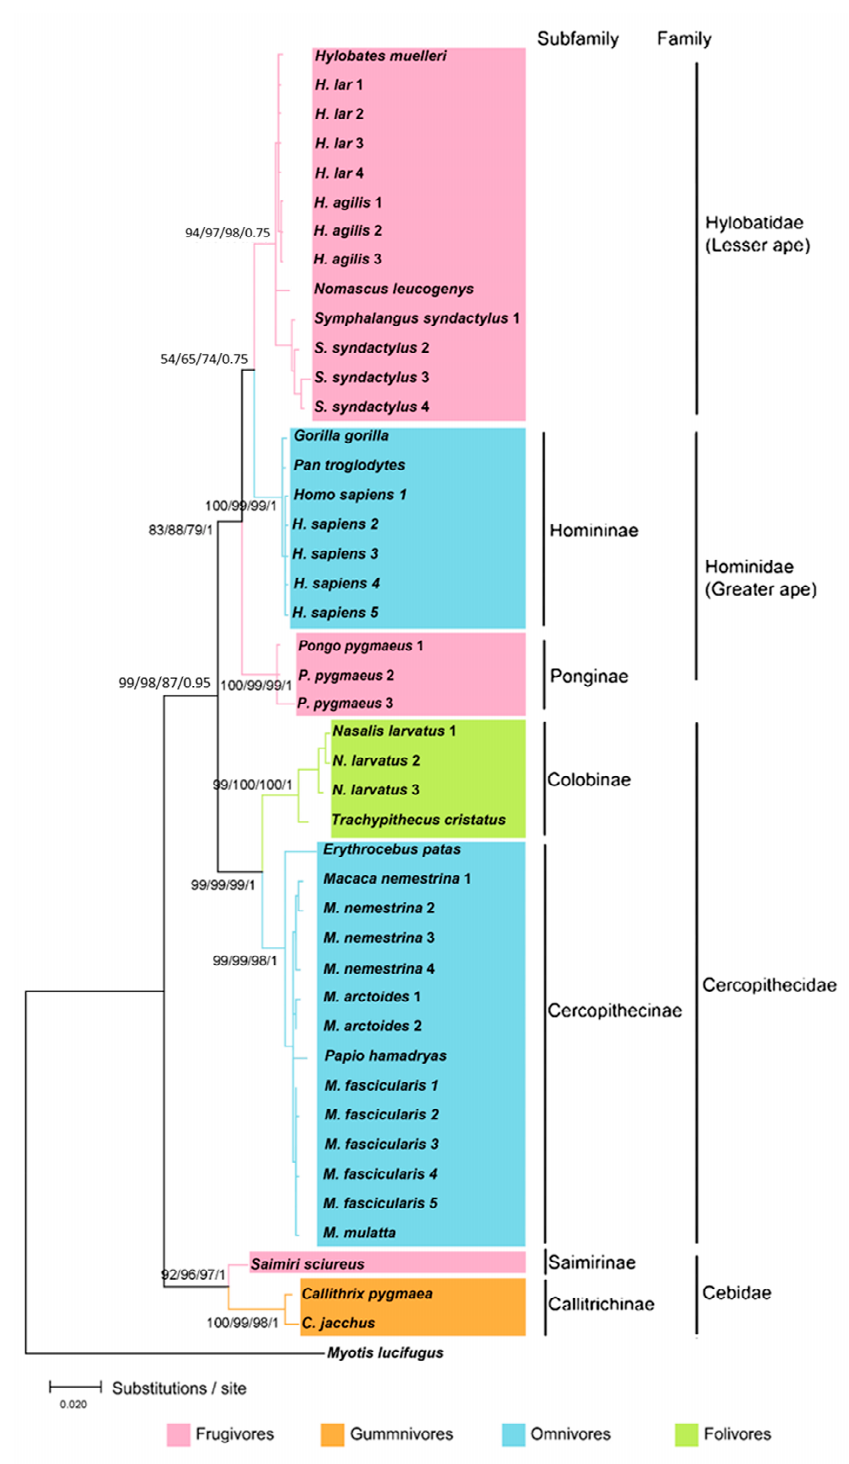
Figure 1. Bayesian phylogram of a 50% majority-rule consensus tree inferred from the alignment of the sweet taste receptor TAS1R2 gene sequences in exon 6 (816 bp). The phylogram comprises 20 primate species with M. lucifugus as an outgroup. Scores on the branches refer to bootstrap support values (1000 iterations) from NJ (1st score), MP (2nd score), ML (3rd score), and Bayesian posterior probabilities (4th